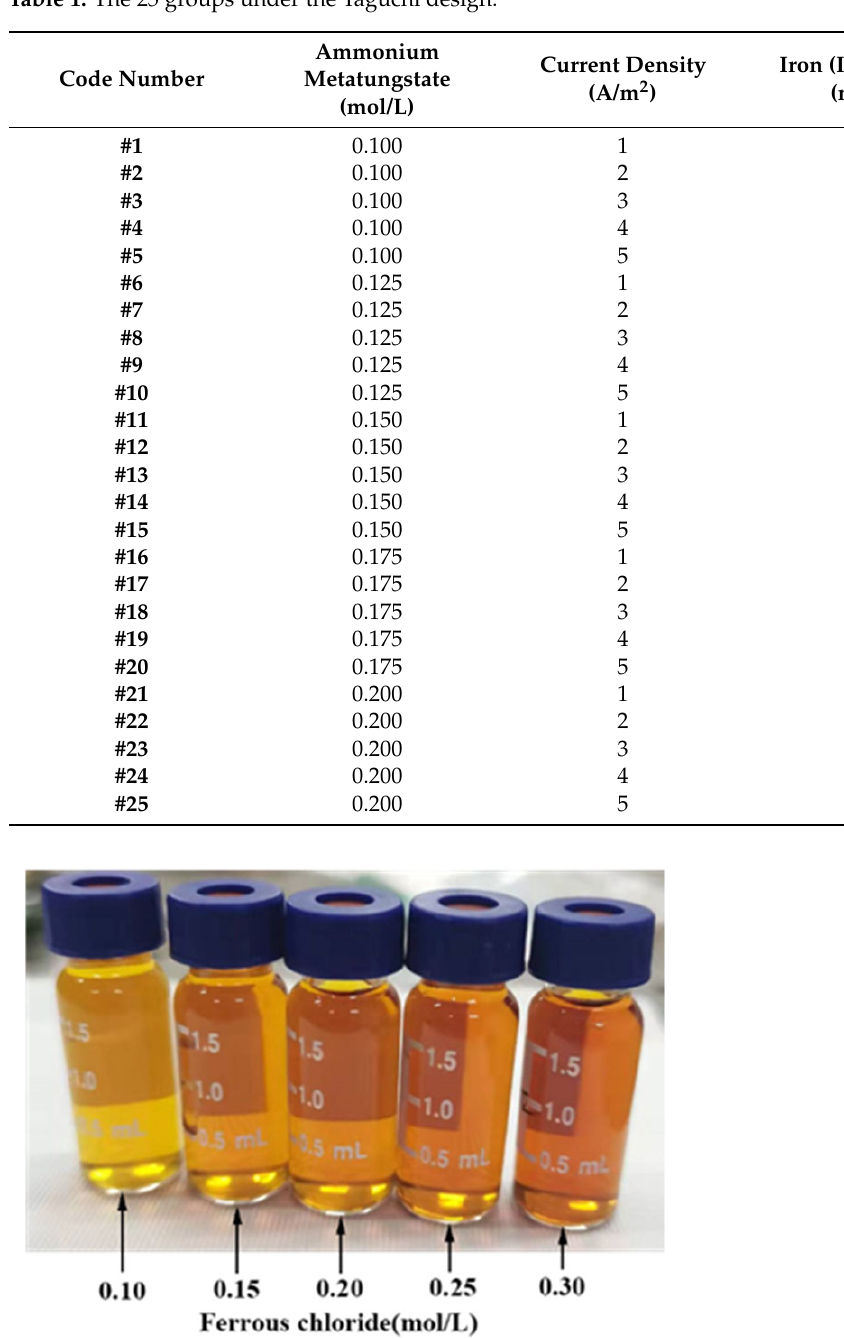
Table 1. The 25 groups under the Taguchi design.